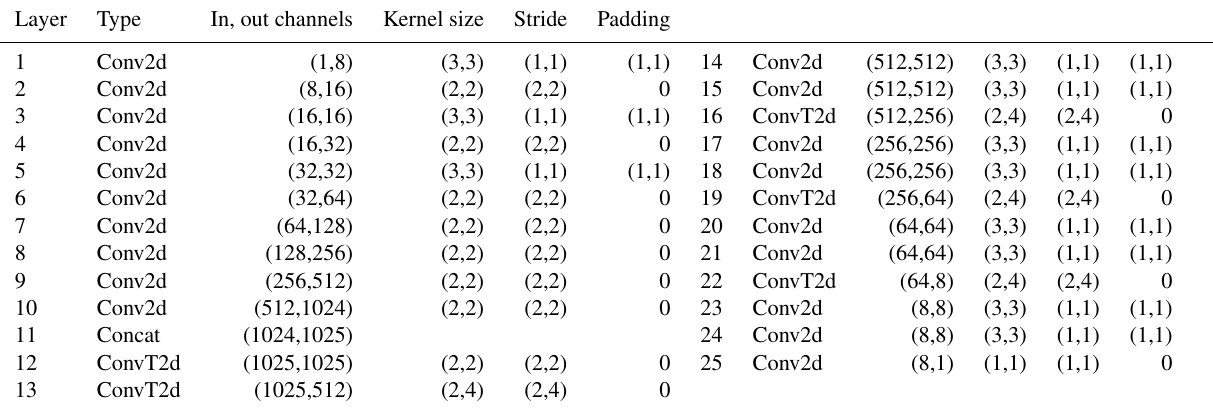
Table A1. Conditional autoencoder layer parameters. Each entry shows the parameterisation of each convolutional layer. The padding column shows the padding on each side of the input tensor for each spatial